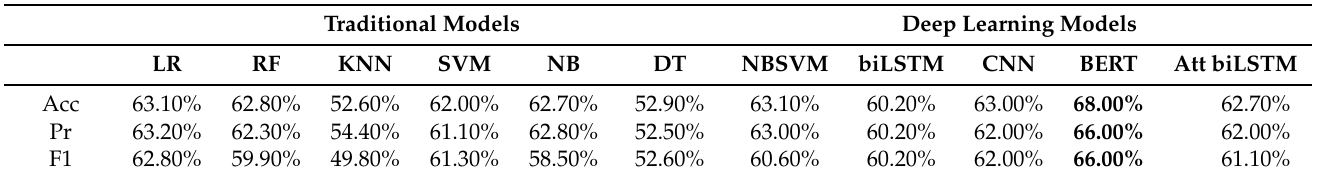
Figure 8. Confusion matrix for BERT (left) for multi-classification and CNN (right) for binary classification. Table 6. Average results of all models. Acc: Accuracy, Pr: precision and F1 score. Bold values indicate the highest performance.